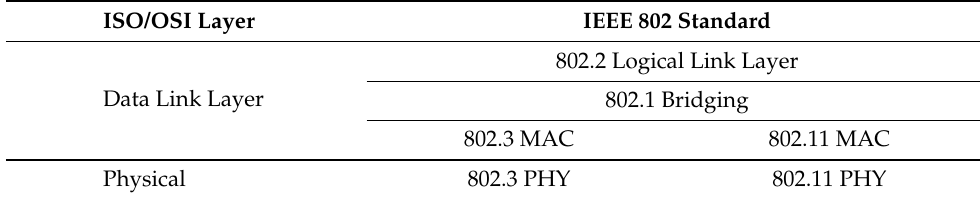
Table 1. IEEE 802.1 Contribution within IEEE 802.